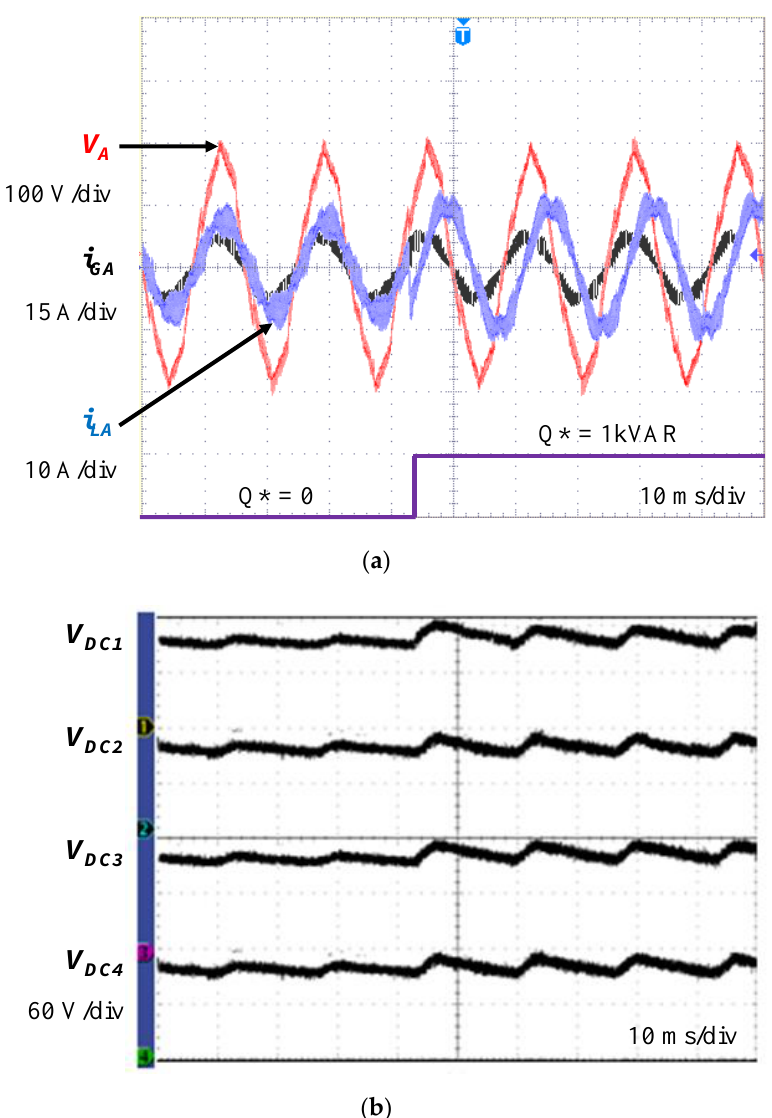
Figure 18. Experimental waveforms of the dynamic performance from resistive to inductive load. ( a ) Grid phase voltage ( V A ), grid phase current ( i GA ), and load current ( i LA ) for Phase A; ( b ) DC-link capacitor voltages ( V DC 1 - V DC 4 ).